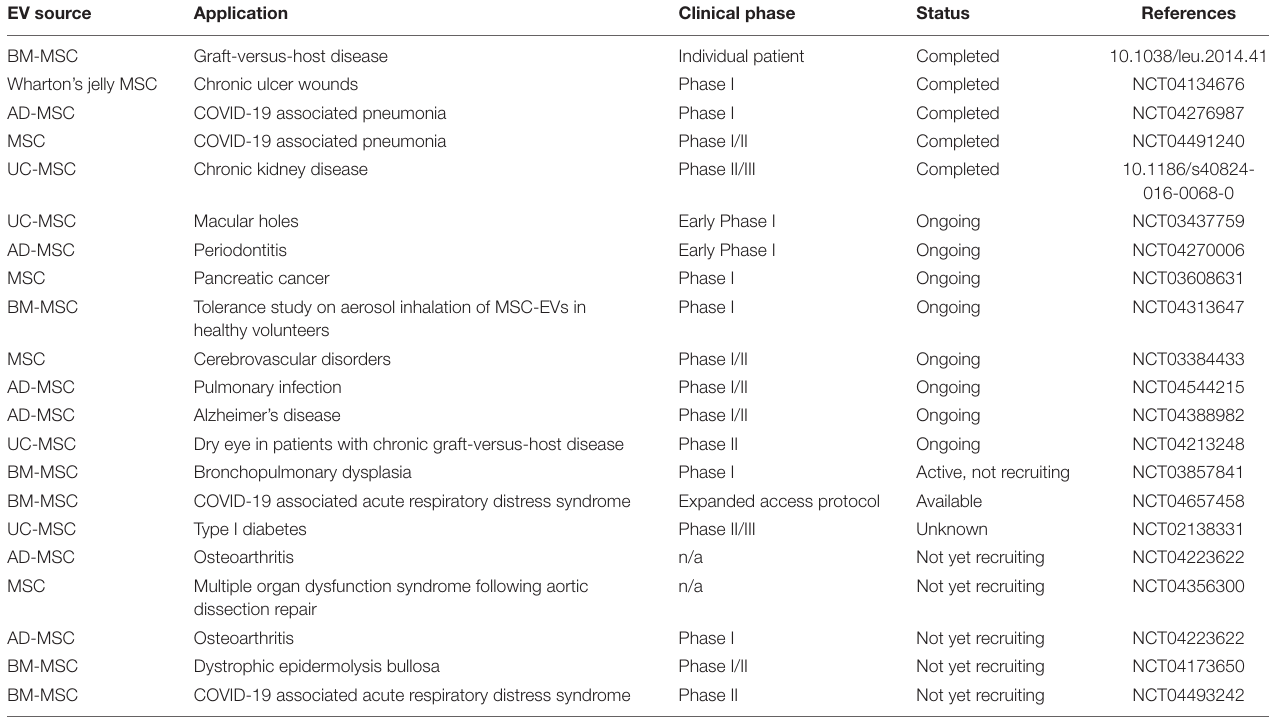
TABLE 2 | List of registered clinical trials using MSC derived EVs.